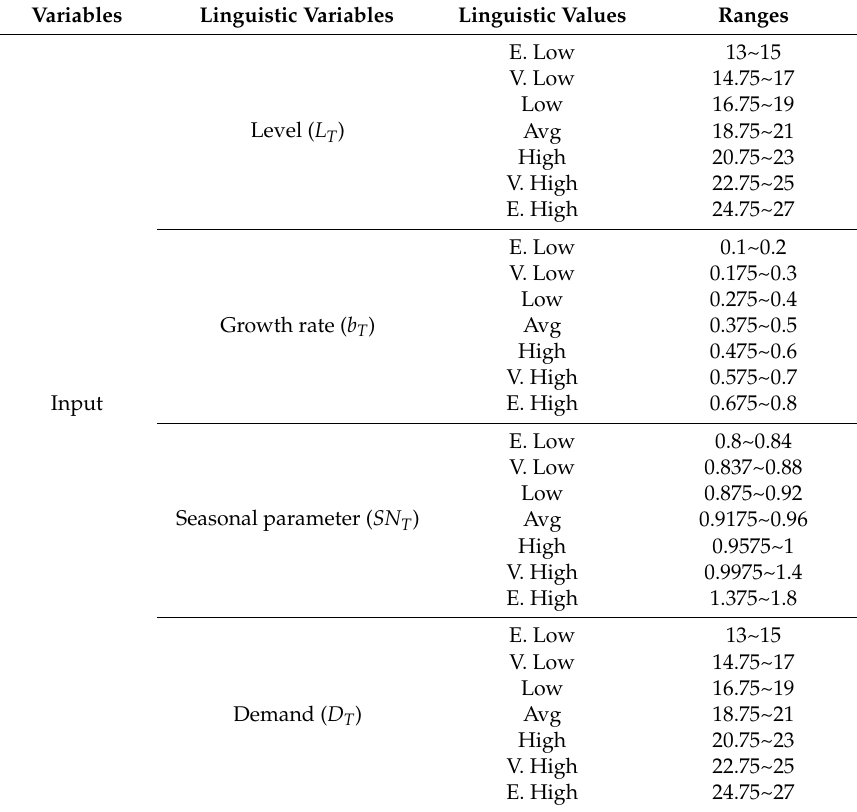
Table 2. Linguistic variables, their associated values and